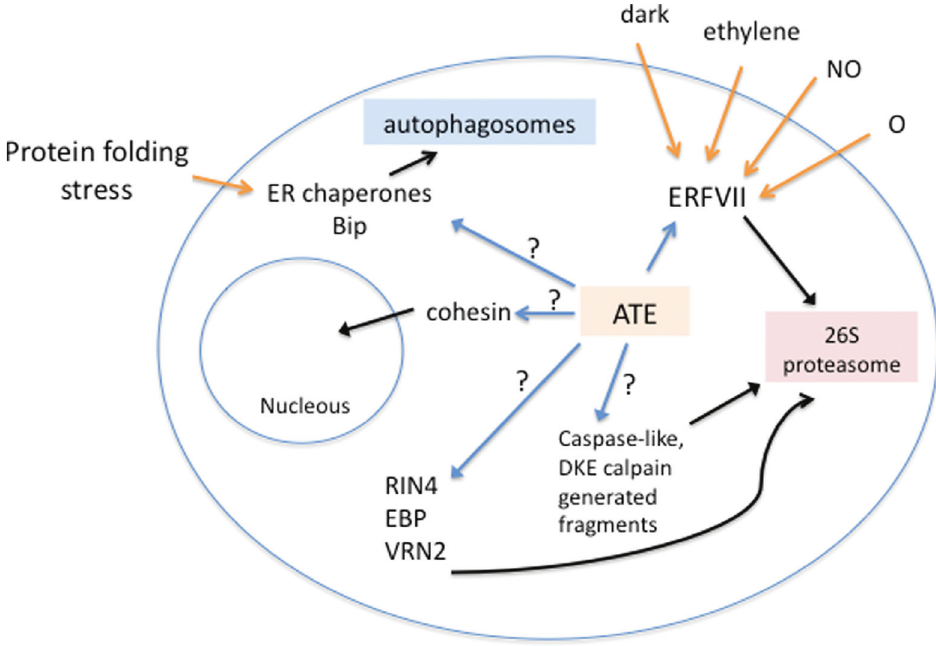
Figure 3 - A proposed model of biological processes regulated by ATE arginylation in plants. Plant ATE putative and confirmed substrates are indicated by blue arrows. Black arrows show the possible fates of N-terminal arginylated proteins. Yellow arrows indicate external signals known to induce N-terminal modifications necessary for ATE substrate recognition, such as ERFVII Cys oxidation induced by oxygen and NO or cytosol translocation of N-terminally cleaved ER chaperones induced by protein folding stress. In this model, we include the putative targets and signaling pathways observed in mammalian cells that have not been tested in plant cells, as indicated by question